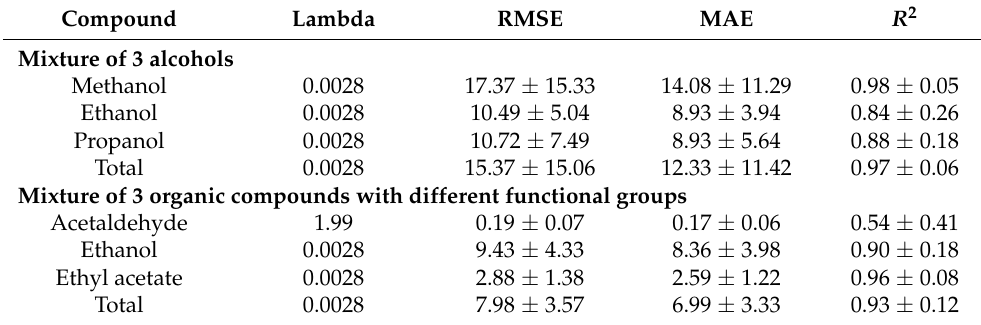
Table 4. Ridge regression performance parameters for the cross-validation with 6 folds and 10